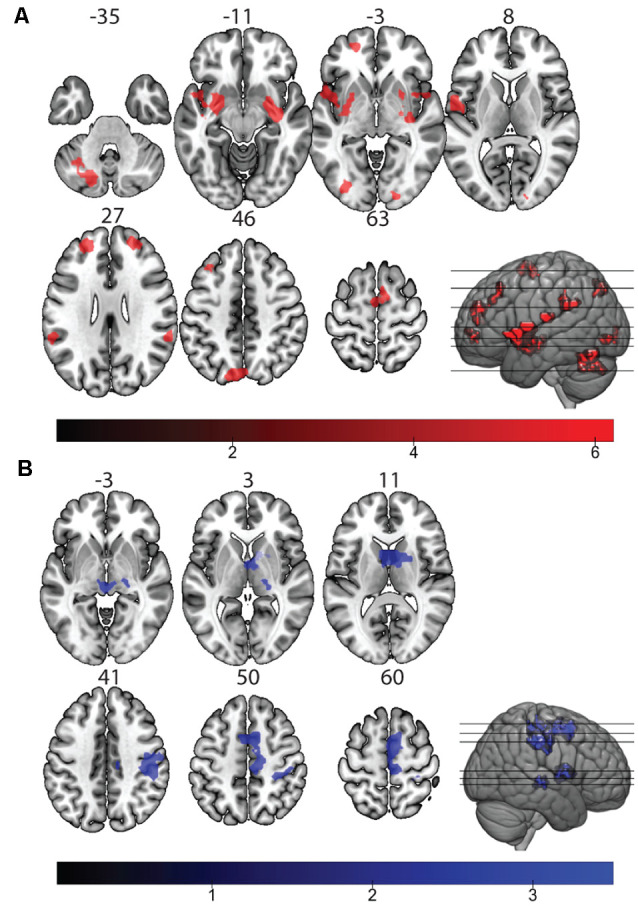
Neural correlates of visual decision confidence and metacognitive efficiency. (A) Significant activity of parametrically increasing decision confidence modeled with the blood-oxygen-level dependent (BOLD) temporal derivative of the canonical hemodynamic response function (HRF; Significance level: pFWE < 0.05). Significant clusters (red) are bilaterally located in the basal forebrain (BF), supplementary eye fields (SEF), inferior parietal lobe (IPL), supramarginal gyrus, mid frontal gyrus, and mid occipital gyrus (MOG). (B) Significant activity of individuals’ metacognitive efficiency correlated with parametrically increasing confidence modeled with a BOLD temporal derivative of the canonical HRF (significance: pcc < 0.05 at the punc < 0.001 voxel threshold). Significant clusters (blue) are located in the SEF, putamen, visual thalamus, and right postcentral gyrus.